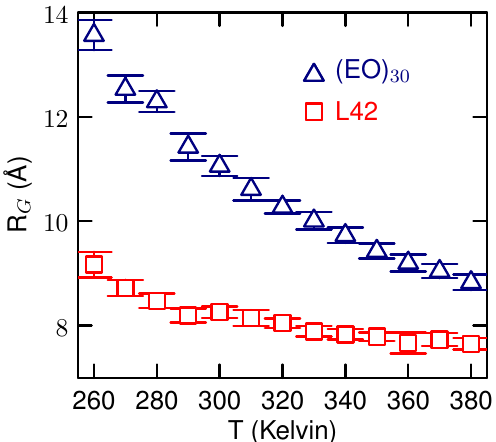
Figure 6. Radius of gyration for a single polymer as a function of temperature.